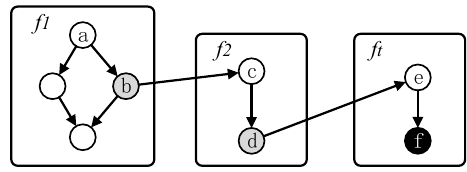
Figure 5. Example of basic block-level distance calculation.